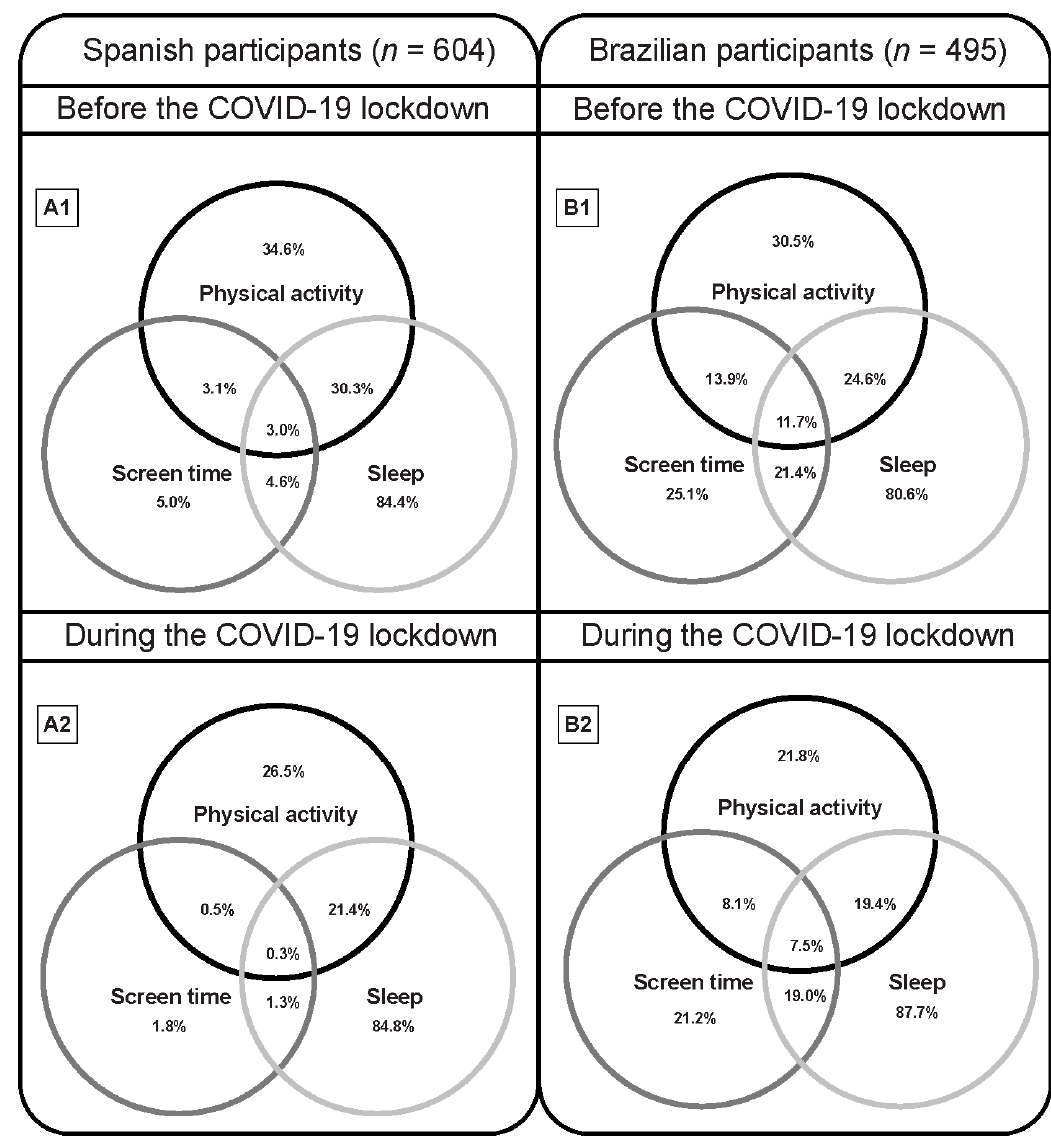
Figure 2. Venn diagram showing the proportion meeting the 24-h guidelines in both Spanish and Brazilian preschoolers, children and adolescents.